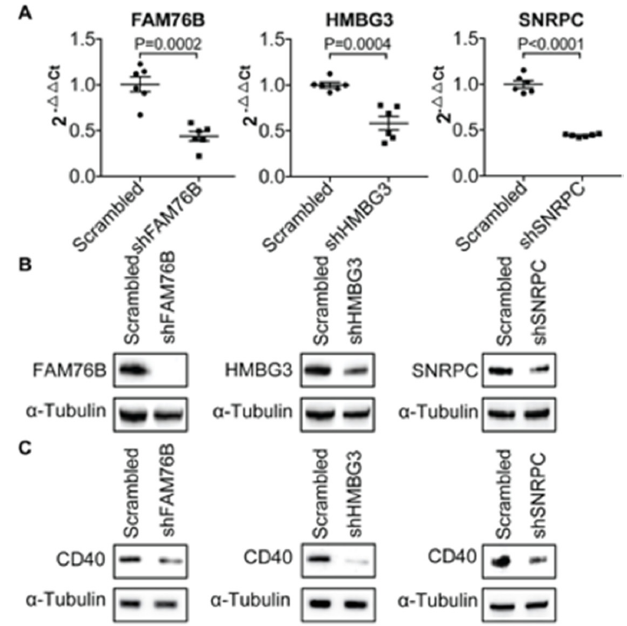
Figure A1. Demonstration of FAM76B, HMGB3 and SNRPC as CD40 transcription regulators in human B cells. ( A ) Knockdown of FAM76B, HMGB3 and SNRPC in human BL2 cells using shRNA as shown by real time PCR. (B) Western blots showing downregulation of FAM76B, HMGB3 and SNRPC results in decreased expression of CD40 in BL2 cells. Whole cell protein was used for Western blots. ( C ) Down-regulation of CD40 expression on mRNA level in the FAM76B, HMGB3 and SNRPC knockdown cells, suggesting a transcriptional regulation of CD40 expression. α -Tubulin was used for loading control. Scrambled: scrambled shRNA control. sh: shRNA.